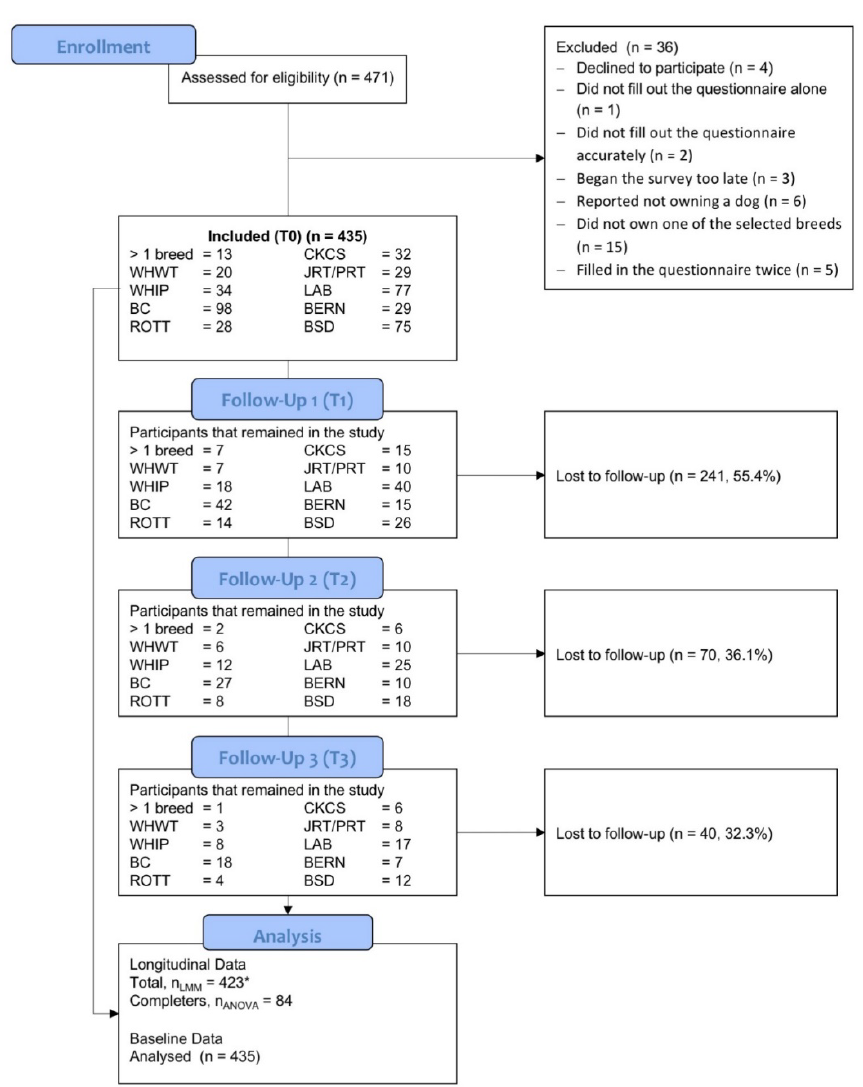
Figure 1. Flow chart of participants over the course of the study. * 12 participants reported owning more than one of the specified dog breeds at all times of the study and were, therefore, excluded from the LMM. BC, Border Collie; BERN, Bernese Mountain Dog; BSD, Belgian Shepherd Dog; CKCS, Cavalier King Charles Spaniel; JRT/PRT, Jack and Parson Russell Terrier; LAB, Labrador Retriever; PA, physical activity; ROTT, Rottweiler; WHIP, Whippet; WHWT, West Highland White